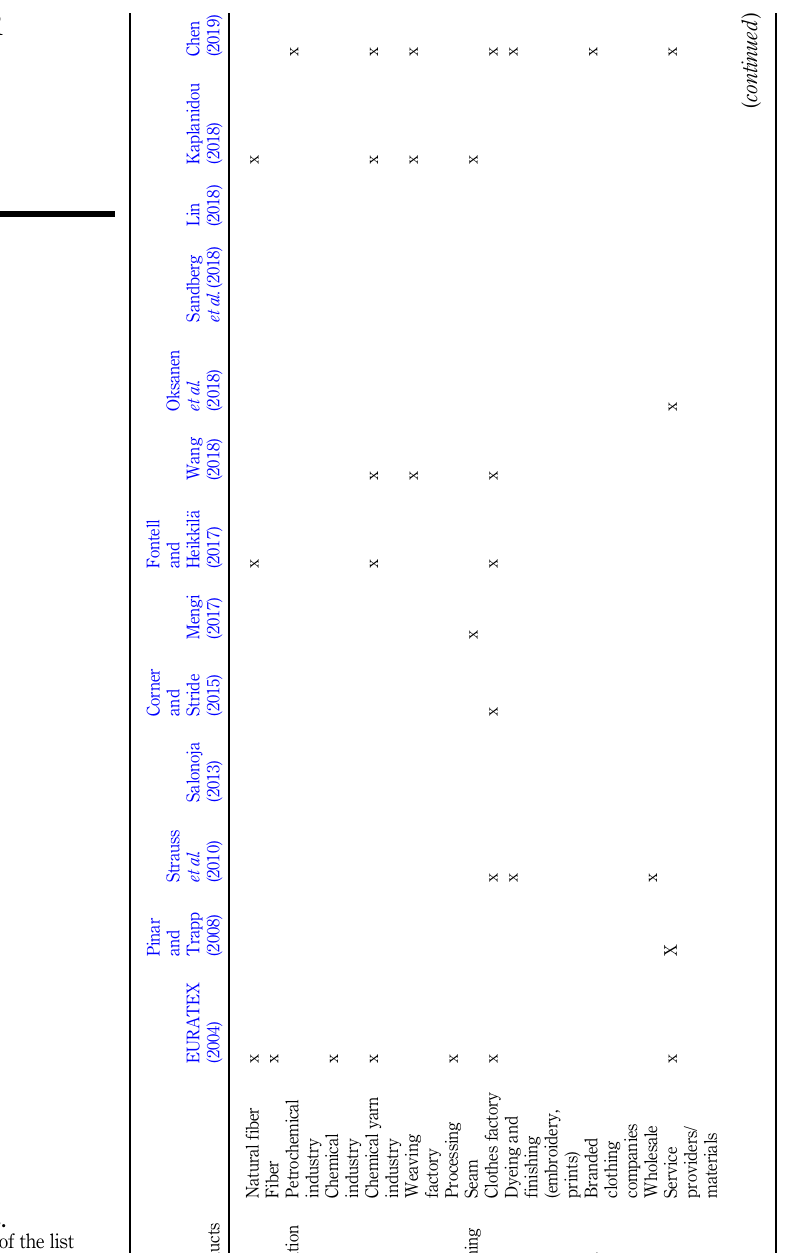
Table 3. Excerpt of the list created from the analysis of studies –